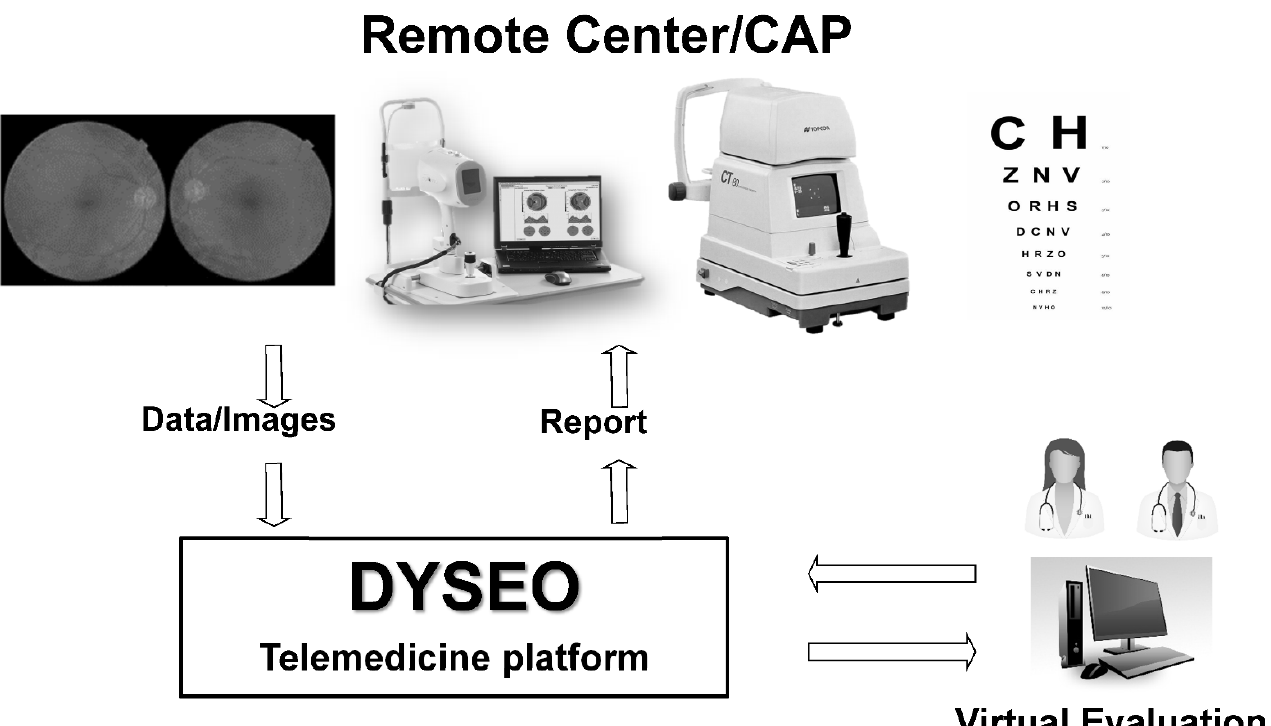
Figure 1. Telemedicine scheme. At the primary care center (remote center), patients were examined, and data were uploaded to the DYSEO platform. Images and data were remotely evaluated and reported on a deferred basis.